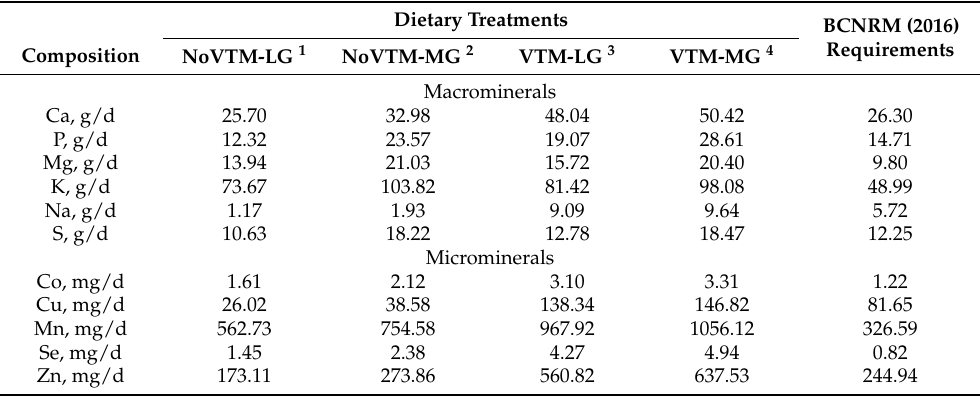
Table 3. Dietary intake of macro and trace minerals and values recommended by the BCNRM (2016; Nutrient Requirements of Beef